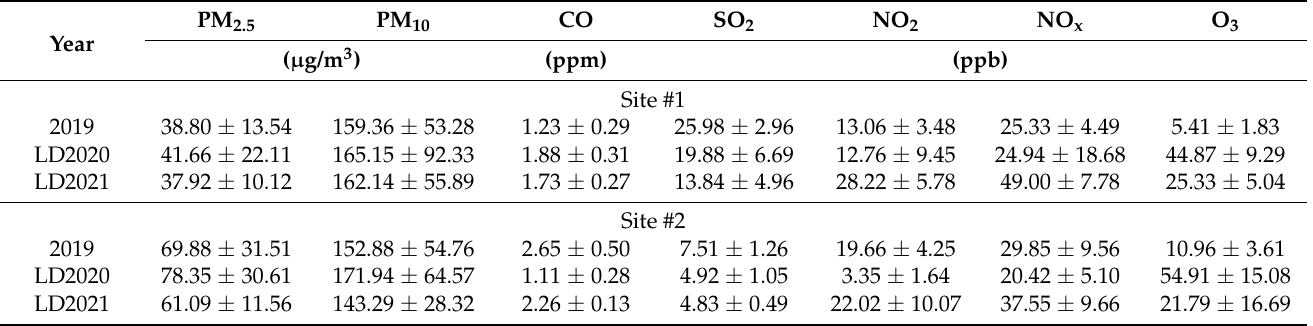
Table 1. Average concentration and standard deviation of pollutants during two successive